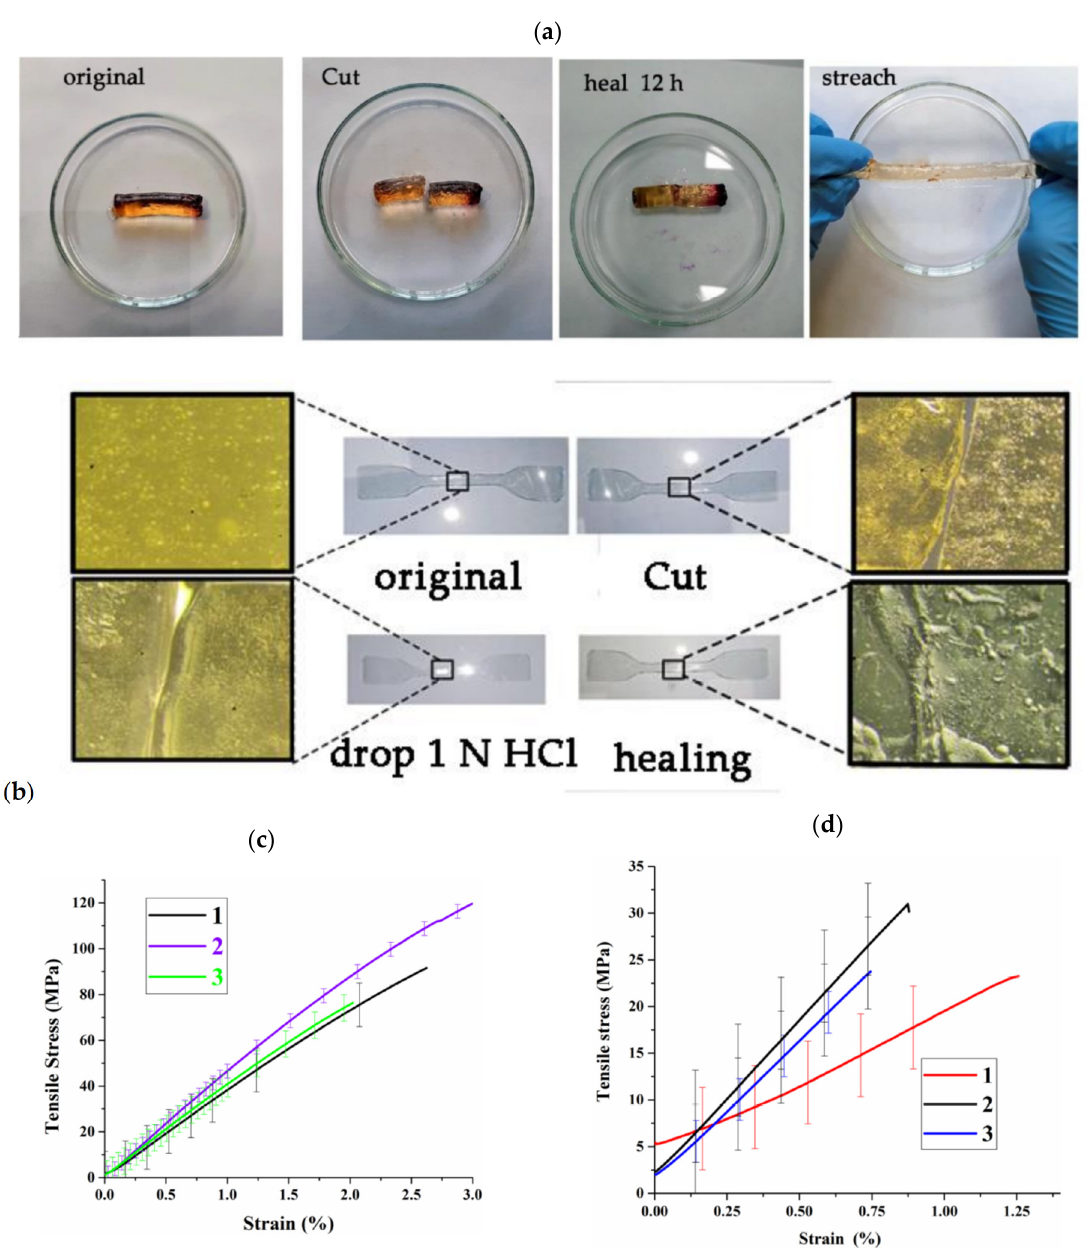
Figure 19. ( a ) Photographs of the healing process of the gel 13 ((AM/AA/ZnAcrylatePhTpy = 49.5/49.5/1) in 50 wt.% sol), demonstrating its mechanical deformation and recoverability. ( b ) Op-